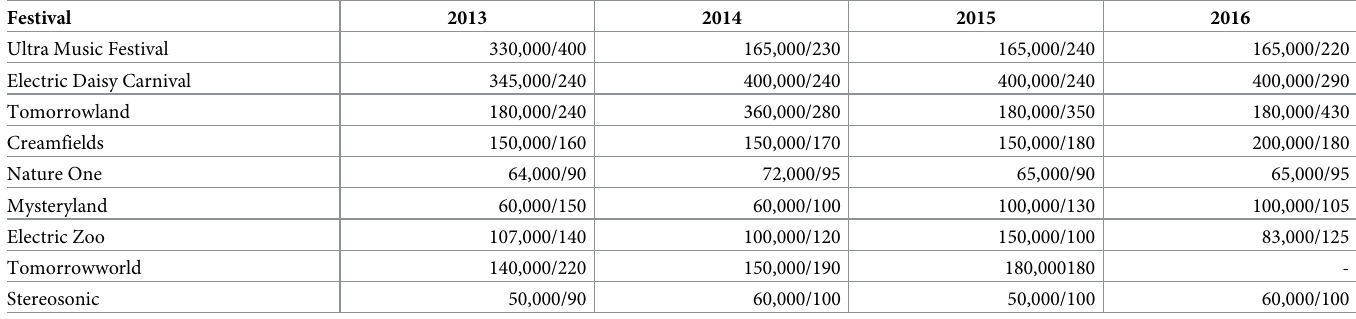
Table 1. Approximate numbers of visitor and performing DJs at the selected